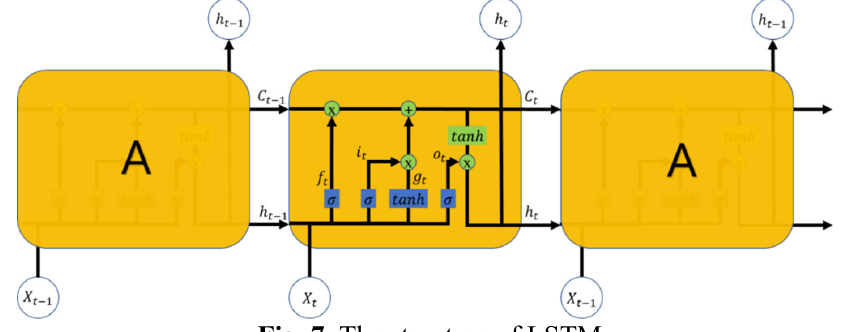
Fig. 7. The structure of